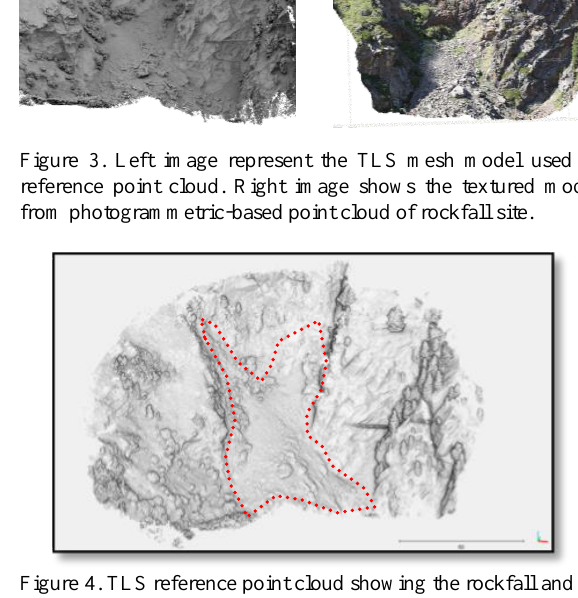
Figure 4. TLS reference point cloud showing the rockfall and its close surroundings. Red circle indicates the debris fan. Note the large failure planes over the upper section and a debris fan at the